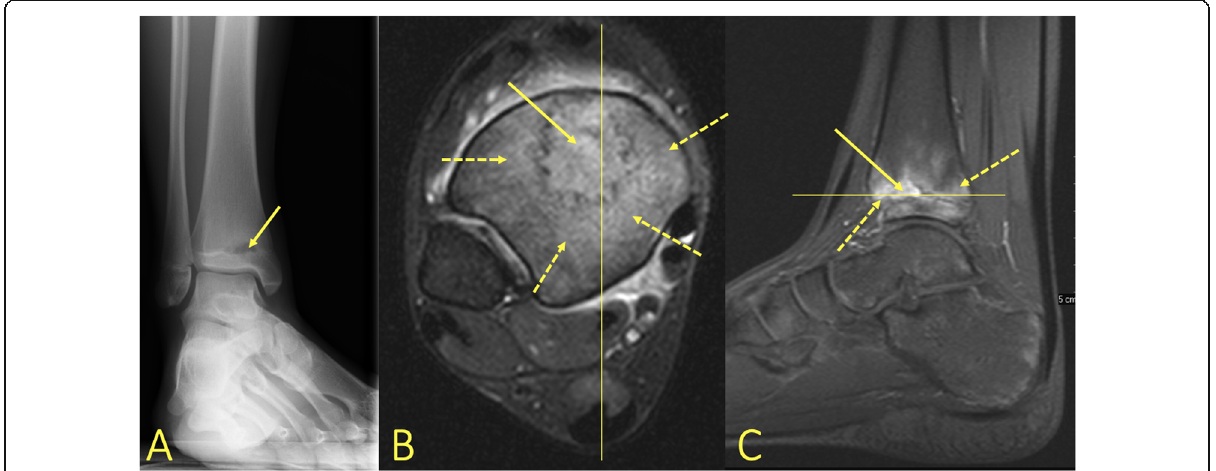
Fig. 26 A 13-year-old female with intermittent moderate ankle pain for 3 weeks. a Radiographs showed a well-defined radiolucent lesion centrally in the distal tibial metaphysis (arrow). b , c MRI showed a Brodie abscess (arrow) with BME (dashed arrows) and contrast enhancement in distal tibia (arrow)